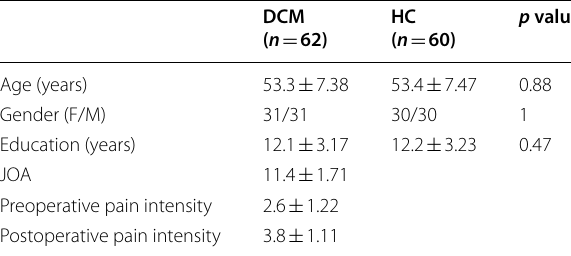
Table 1 Demographic data of the two